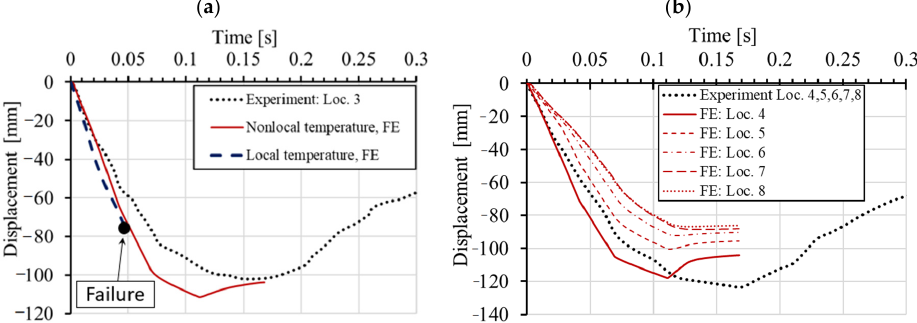
Figure 11. Experimentally measured and calculated displacement time histories: ( a ) Location 3 and ( b ) Locations 4 to